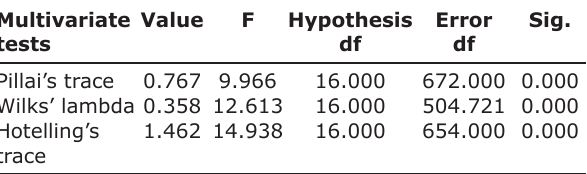
Table-2: MANOVA test used to estimate the significance of the relationship between reproductive conditions and hormones (estradiol, progesterone, prostaglandin, and oxytocin). Multivariate tests